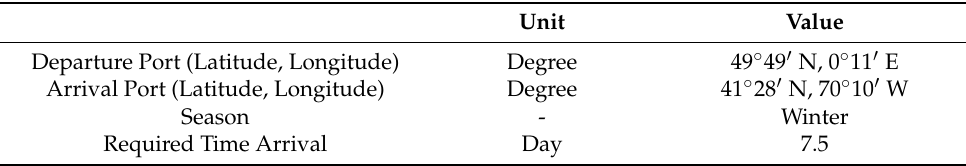
Table 9. The Atlantic route Table 8. Pacific case—accumulated FOC and gas emission results.